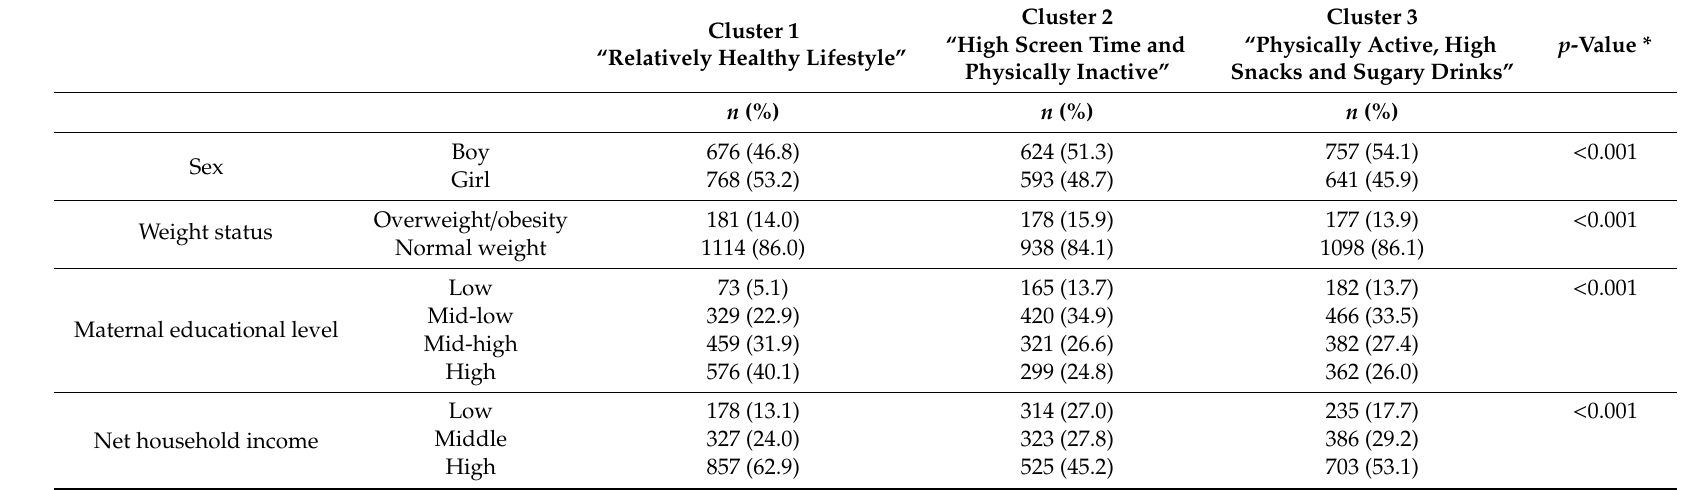
Table 3. Child lifestyle clusters according to child characteristics and socioeconomic status ( n = 4059).